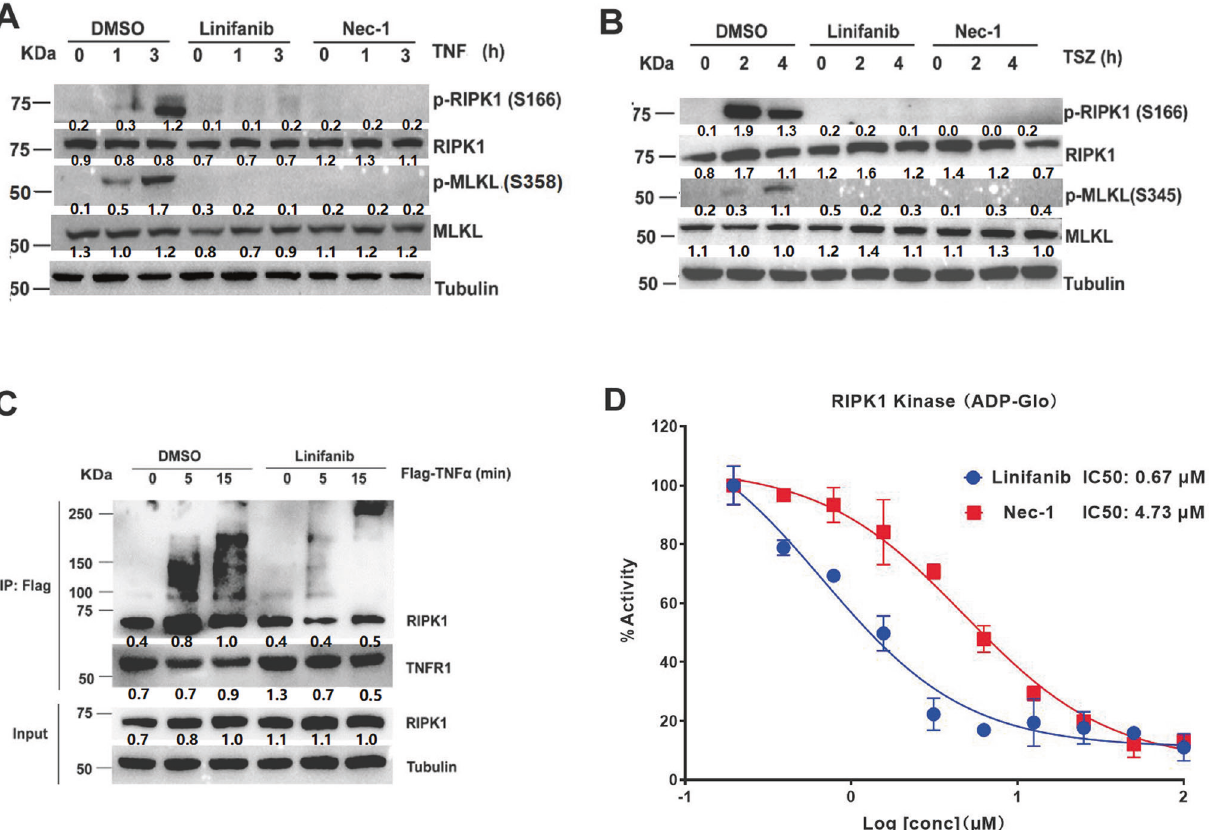
Fig. 5 Linifanib prevents RIPK1-mediated cell death and is a RIPK1 kinase inhibitor. A FADD-de fi cient Jurkat cells were pretreated with linifanib (10 µM), Nec-1 (25µM) or DMSO for 30 min followed by stimulation with hTNF- α (50ng/mL) for the indicated time. The expression levels and activation status (phosphorylation) of the indicated necrosome members p-RIPK1 S166 and p-MLKL S345 were analyzed by western blotting using the indicated speci fi c antibodies. Data shown are representative of two independent experiments. B MEFs cells were pretreated with DMSO, linifanib (5 µM), Nec-1 (25µM) plus Smac mimetic (200nM) and z-VAD-fmk (20µM) followed by stimulation with mTNF- α (25 ng/mL) for the indicated durations. C TNF- α -induced complex I immunoprecipitation (IP) of MEFs cells treated in the absence or presence of linifanib (0.31µM) with Flag-mTNF- α (100 ng/ml) for the indicated time points, followed by anti-Flag beads and western blotting analysis using the indicated antibodies. Lysates pre-IP (input) were also analyzed by western blotting using the indicated antibodies. D In vitro ADP-Glo ™ kinase assays using recombinant human RIPK1 protein (200 nM). Recombinant hRIPK1 was incubated with linifanib and Nec-1 at the indicated concentrations. Data represent mean value ±S.D. of two independent 150 mM NaCl, 1 mM PMSF, 1 mM NaF/Na3VO4 and Pierce Protease Inhibitor). Complex I was puri fi ed by IP using Anti-Flag ® M2 Af fi nity Gel (20 µl). The IP protein was rotated overnight at 4 °C.